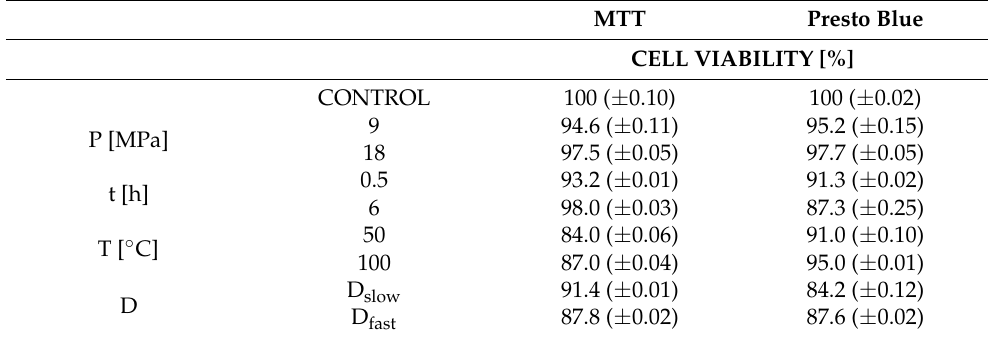
Table 2. Effect of PCL foaming process execution conditions: pressure, temperature, saturation time, decompression rate on cell